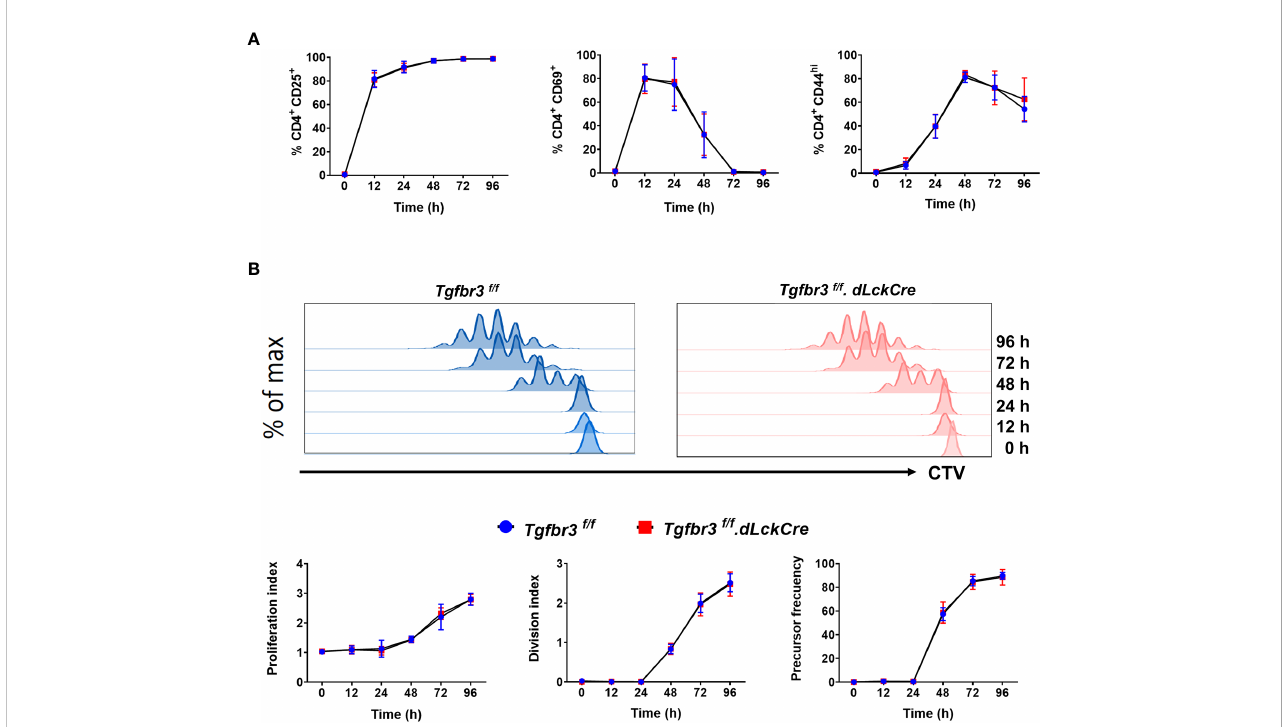
FIGURE 4 In vitro activation of CD4 + T cells from Tgfbr3 fl / fl and Tgfbr3 fl / fl .dLckCre mice. (A ) Expression of the activation markers CD25, CD44 and CD69 was analyzed at 0, 12, 24, 48, 72, and 96 h on sorted naïve T cells stimulated with anti-CD3/anti-CD28. (B ) Proliferation of naïve T cells from Tgfbr3 fl / fl (blue) and Tgfbr3 fl / fl .dLcKCre (red) mice was evaluated by CTV dilution. Histograms from a representative experiment are shown. Data are expressed as proliferation index, division index and precursor frequency for each time point (see methods). Graphs represent mean ± SEM (n = 5 independent experiments, 5 mice per